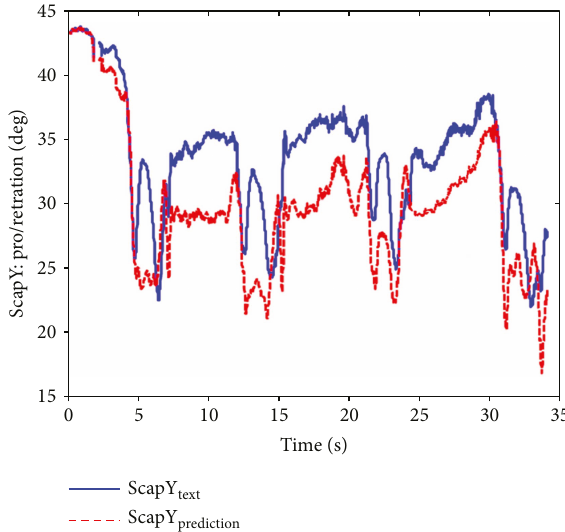
Figure 13: The curve of joint angle θ